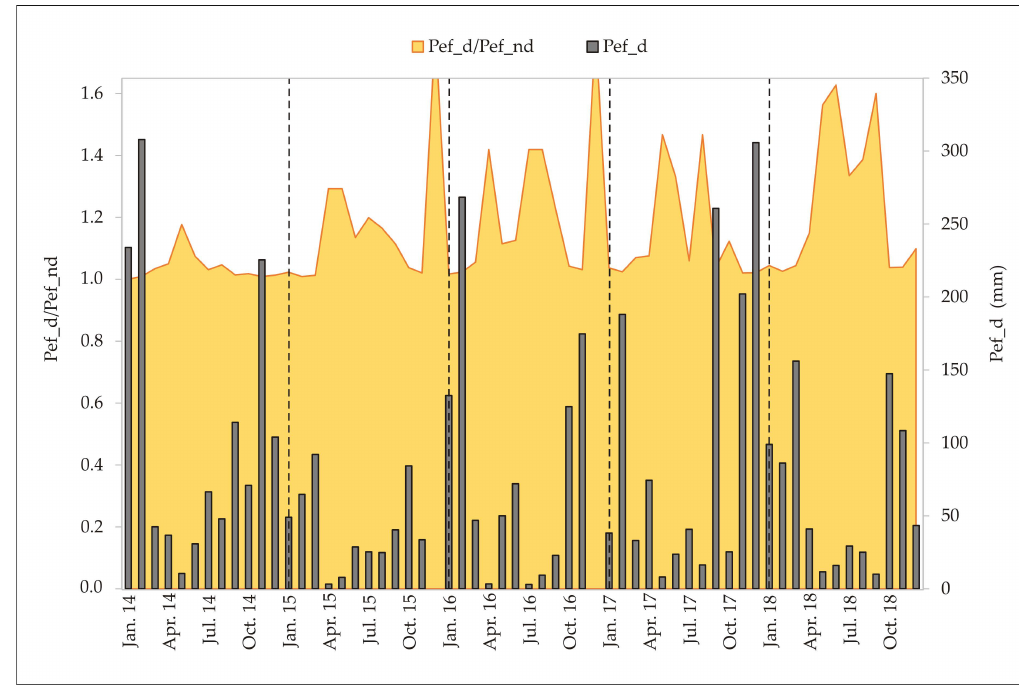
Figure 4. The ratio between monthly values of P ef calculated for the conditions with the large-scale forest disturbances in the catchment of the Unica River (Pef_d) and with the assumption that they would not appear (Pef_nd). To indicate the di ff erences between the dry and wet periods, the monthly values of Pef_d are presented too.